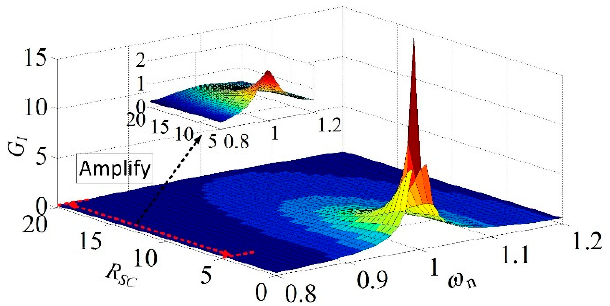
Figure 10. Current gain G I vs. R SC and ω n .